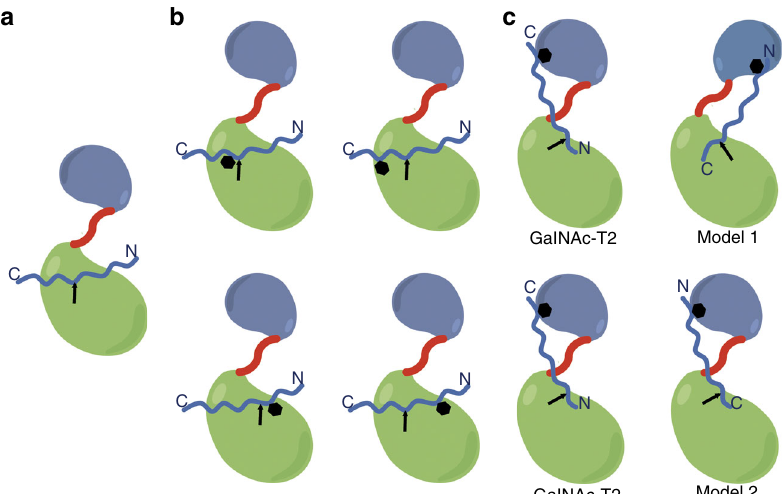
Fig. 1 Modes of O -glycosylation found for the GalNAc-Ts. a – c These panels denote the three distinct modes of O -glycosylation performed by GalNAc-Ts: the neighboring glycosylation activity by the catalytic domain in a and b , and long-range lectin domain-mediated glycosylation activity in c . In c , two plausible models are suggested that might explain the different long-distance glycosylation preferences of GTs such as GalNAc-T3/T4/T16/T12. Oval- shaped fi gures in blue and green depict the lectin and catalytic domains, respectively. Peptides are indicated in blue and the black hexagon-shaped fi gure denotes the position of prior GalNAc moieties in the glycopeptides. Arrows indicate the positions of acceptor